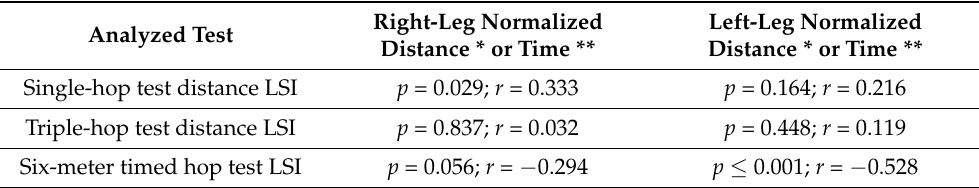
Table 2. Correlations between single-hop test distance LSI and * normalized single-hop test distance separately for right and left leg; triple-hop test distance LSI and * normalized single-hop test distance separately for right and left leg, and six-meter timed hop test LSI and ** time of the six-meter timed hop test separately for right and left